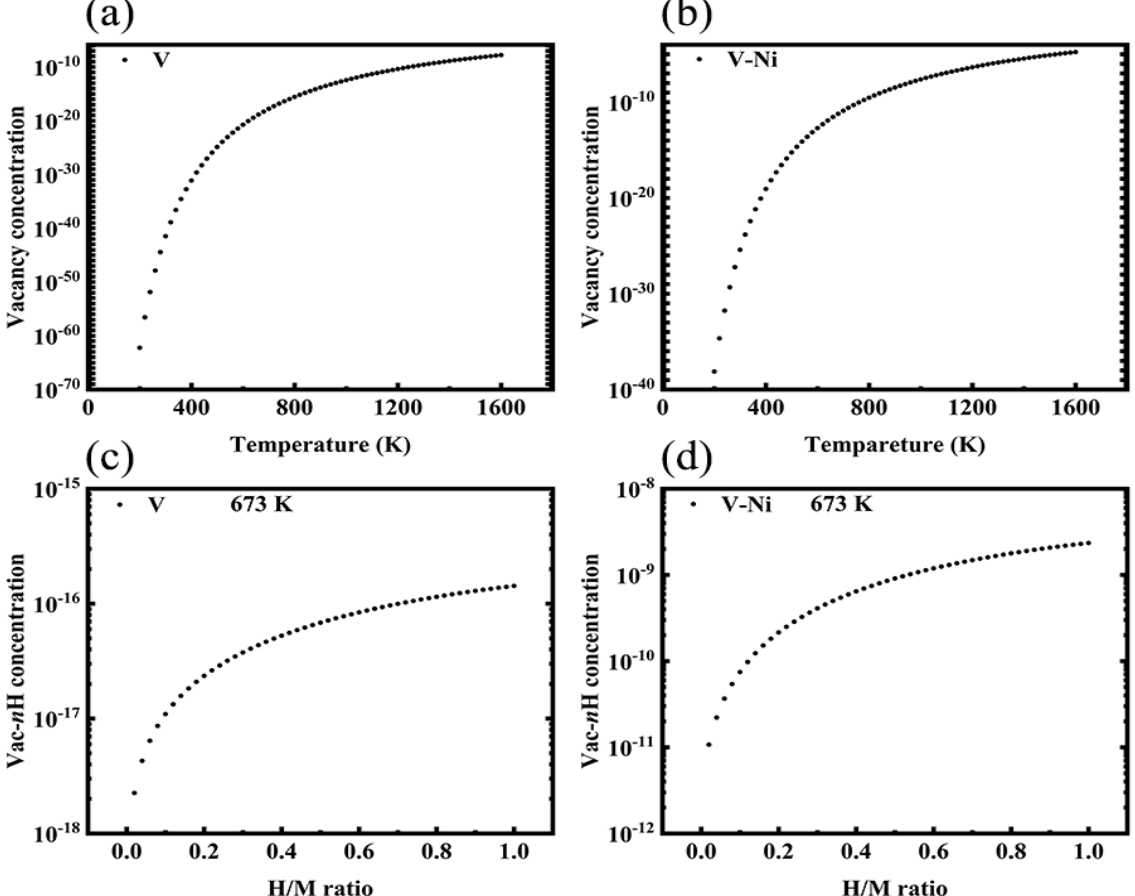
Figure 7. ( a , b ) Monovacancy concentration as a function of temperature; ( c , d ) functional relationship between Vac- n H cluster and H/M ratio.